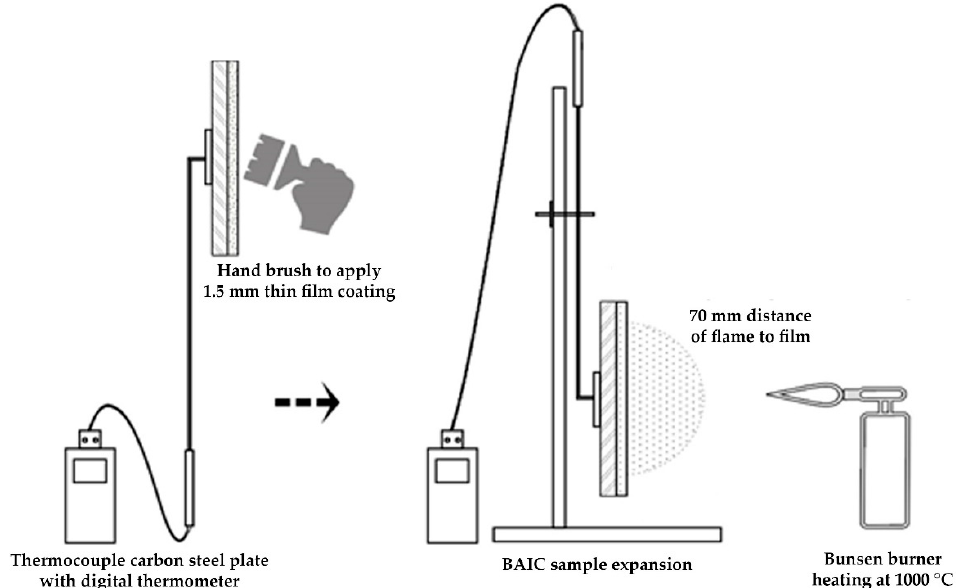
Figure 1. Fire resistance test.